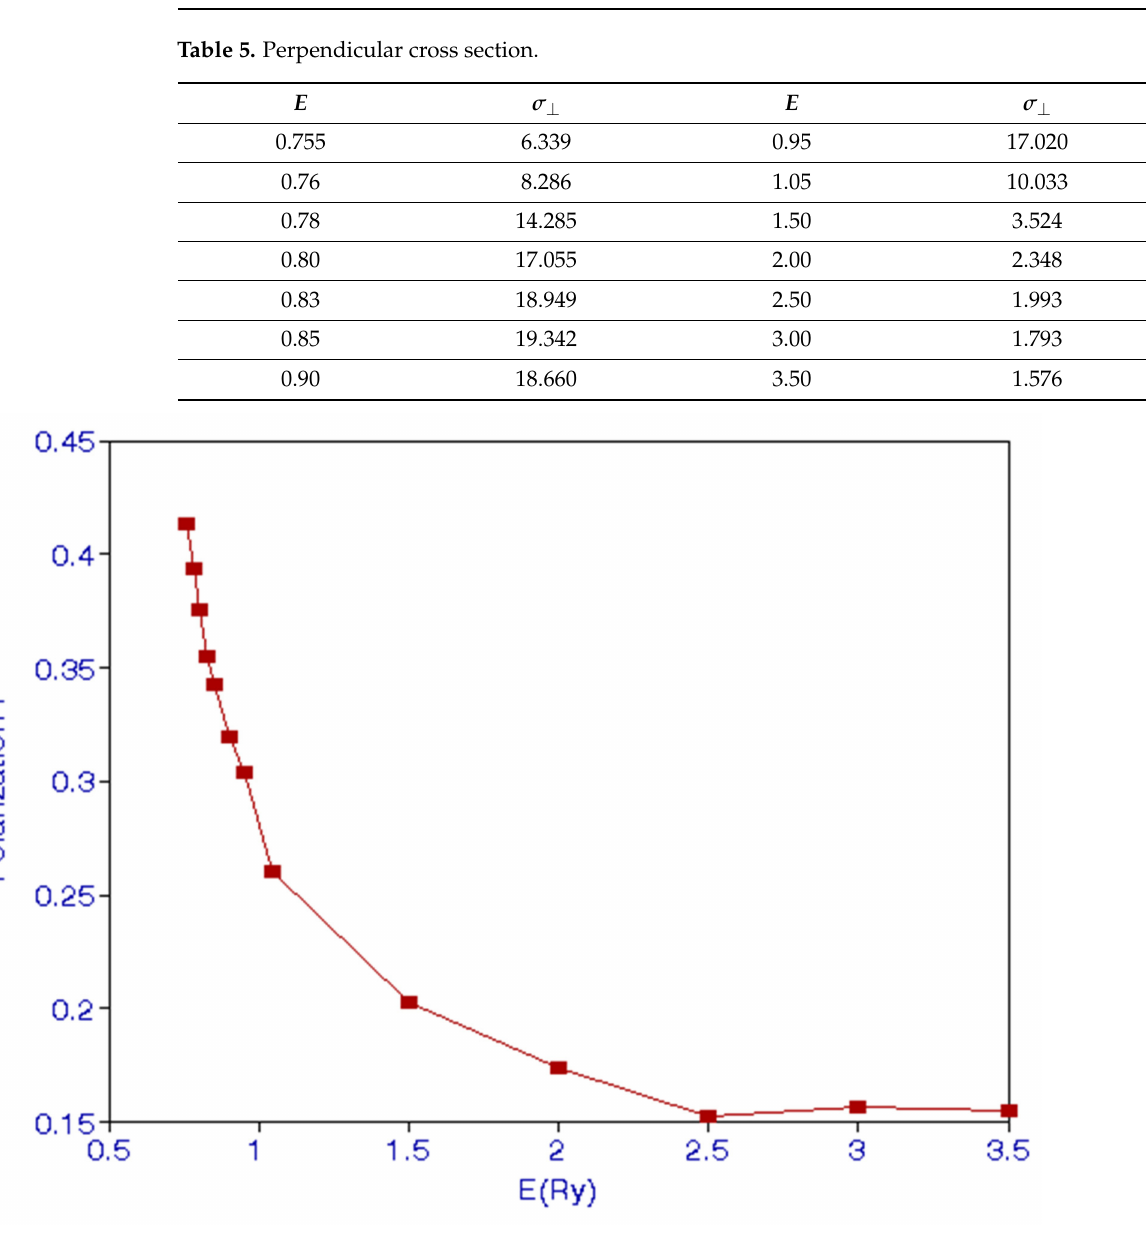
Figure 3. (Color online) Behavior of polarization P with E